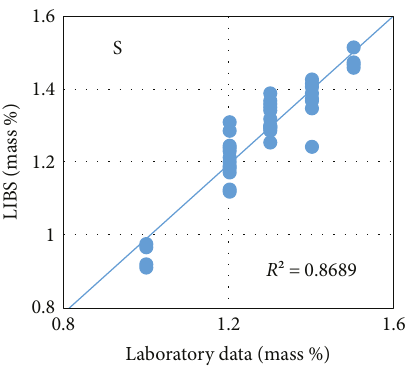
Figure 10: Sulphur content determined by LIBS versus laboratory data. Solid line is a linear fi t for data